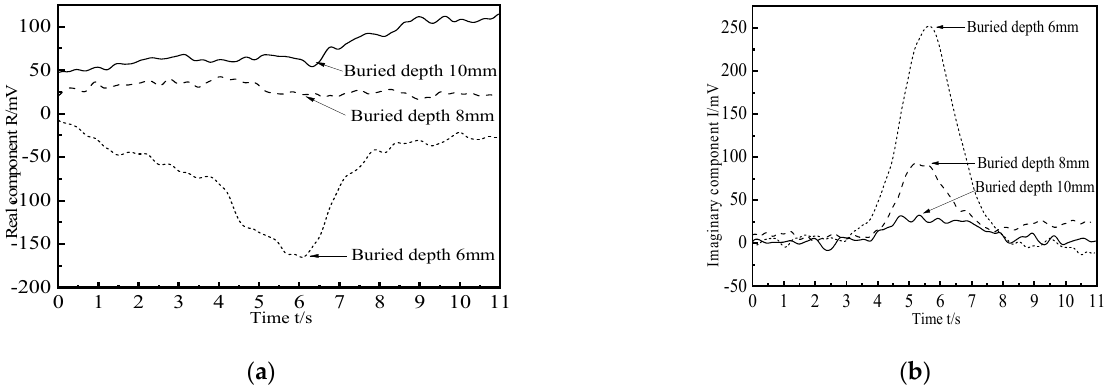
Figure 22. Real and imaginary components of crack-like defect detection signals with different buried depths. ( a ) Real component; ( b ) Imaginary component.